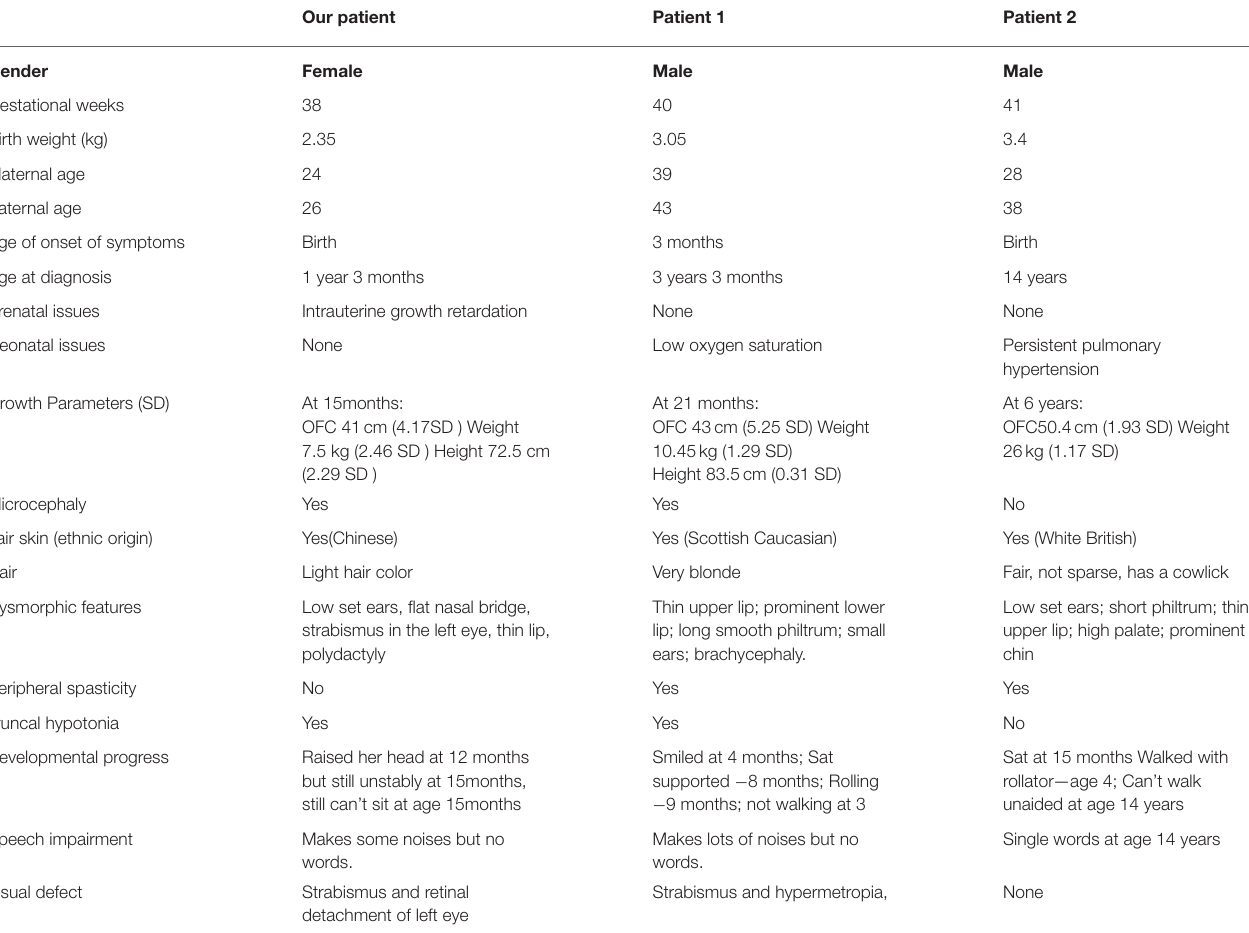
TABLE 1 | Clinical findings in our patient and patients reported (4) before with the same mutation. Our patient Patient